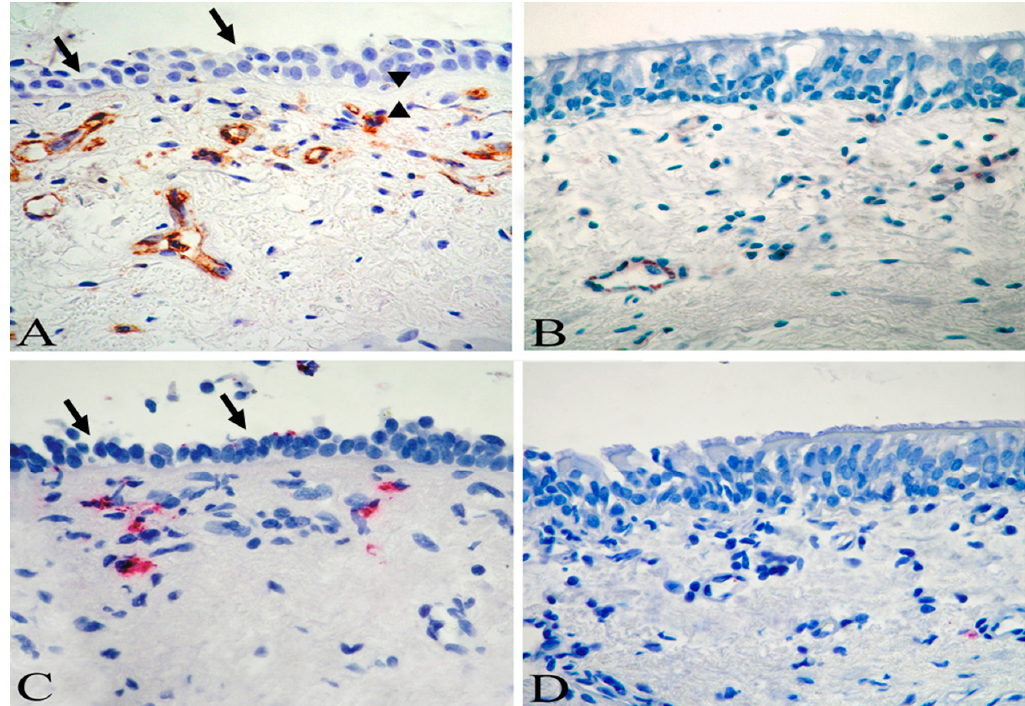
Figure 1. Biopsy sections from a child with asthma ( A and C ), and a control child ( B and D ). An increased number of subepithelial vessels ( A , brown) and eosinophils ( C , red) are demonstrated in the child with asthma. The arrows indicate loss of epithelial cells ( A and C ), while the arrowheads indicate reticular basement membrane thickening ( A ). Immunostaining with monoclonal antibody anti-CD31 ( A and B ) and anti-EG2 ( C and D ). Original magnification × 630. Reprinted with permission of the American Thoracic Society from [30]. Table 1. Histopathologic changes in bronchial biopsies of asthmatic / wheezing children. Number of Mean Age RBM Epithelial SM Submucosal Children (years) Thickening Loss Enlargement Inflammation